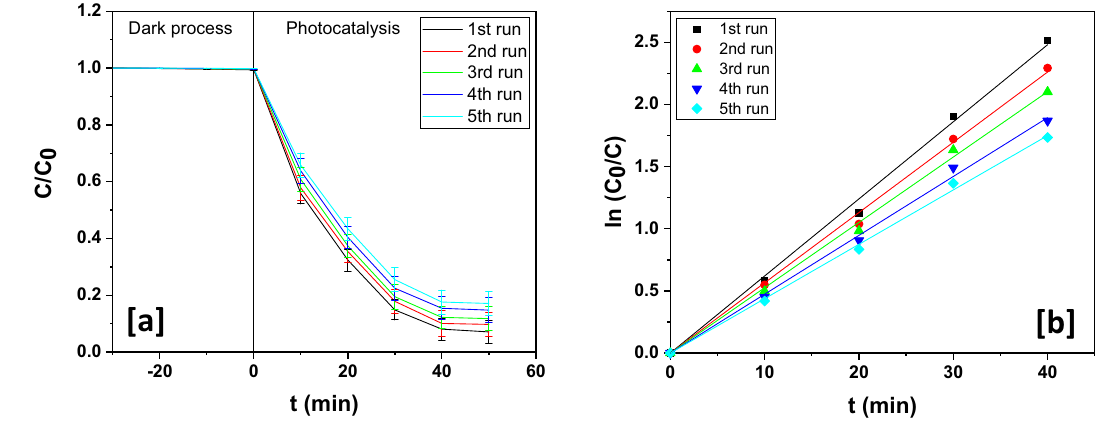
Figure 9. ( a ) Photodegradation dynamic curves of esomeprazole for five consecutive runs over In 2 O 3 /MoS 2 / Fe 3 O 4 and ( b ) its corresponding kinetics.